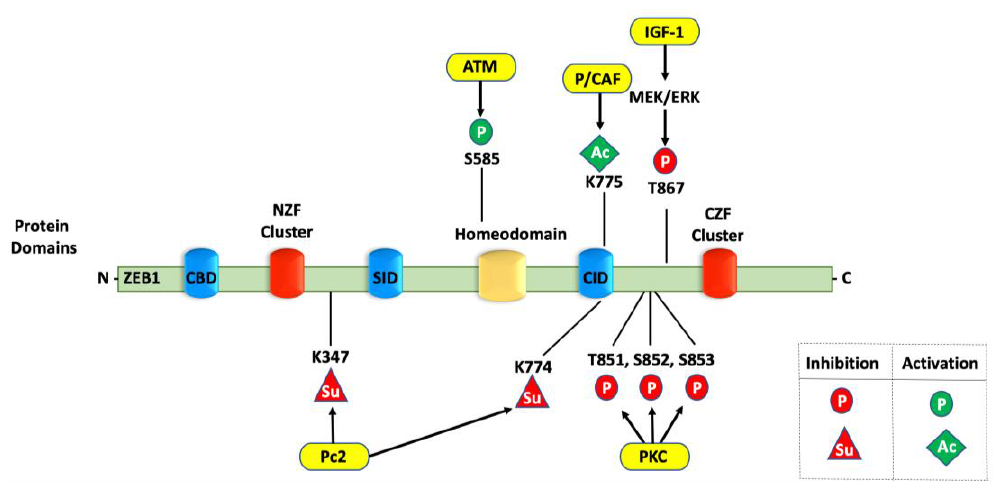
Figure 2. Post-translational modifications controlling ZEB1 function. The ZEB1 protein with its two terminal zinc finger domains (NZF and CZF) and interaction domains (CBD, SID, and CID) is shown. The covalent (i.e., post-translational) modifications that activate or inhibit ZEB1 function are shown in green and red, respectively. The circles indicate phosphorylation (P); the diamond indicates acetylation (Ac); and the triangles indicate sumoylation (Su). The yellow ovals indicate the enzymes catalyzing these modifications.